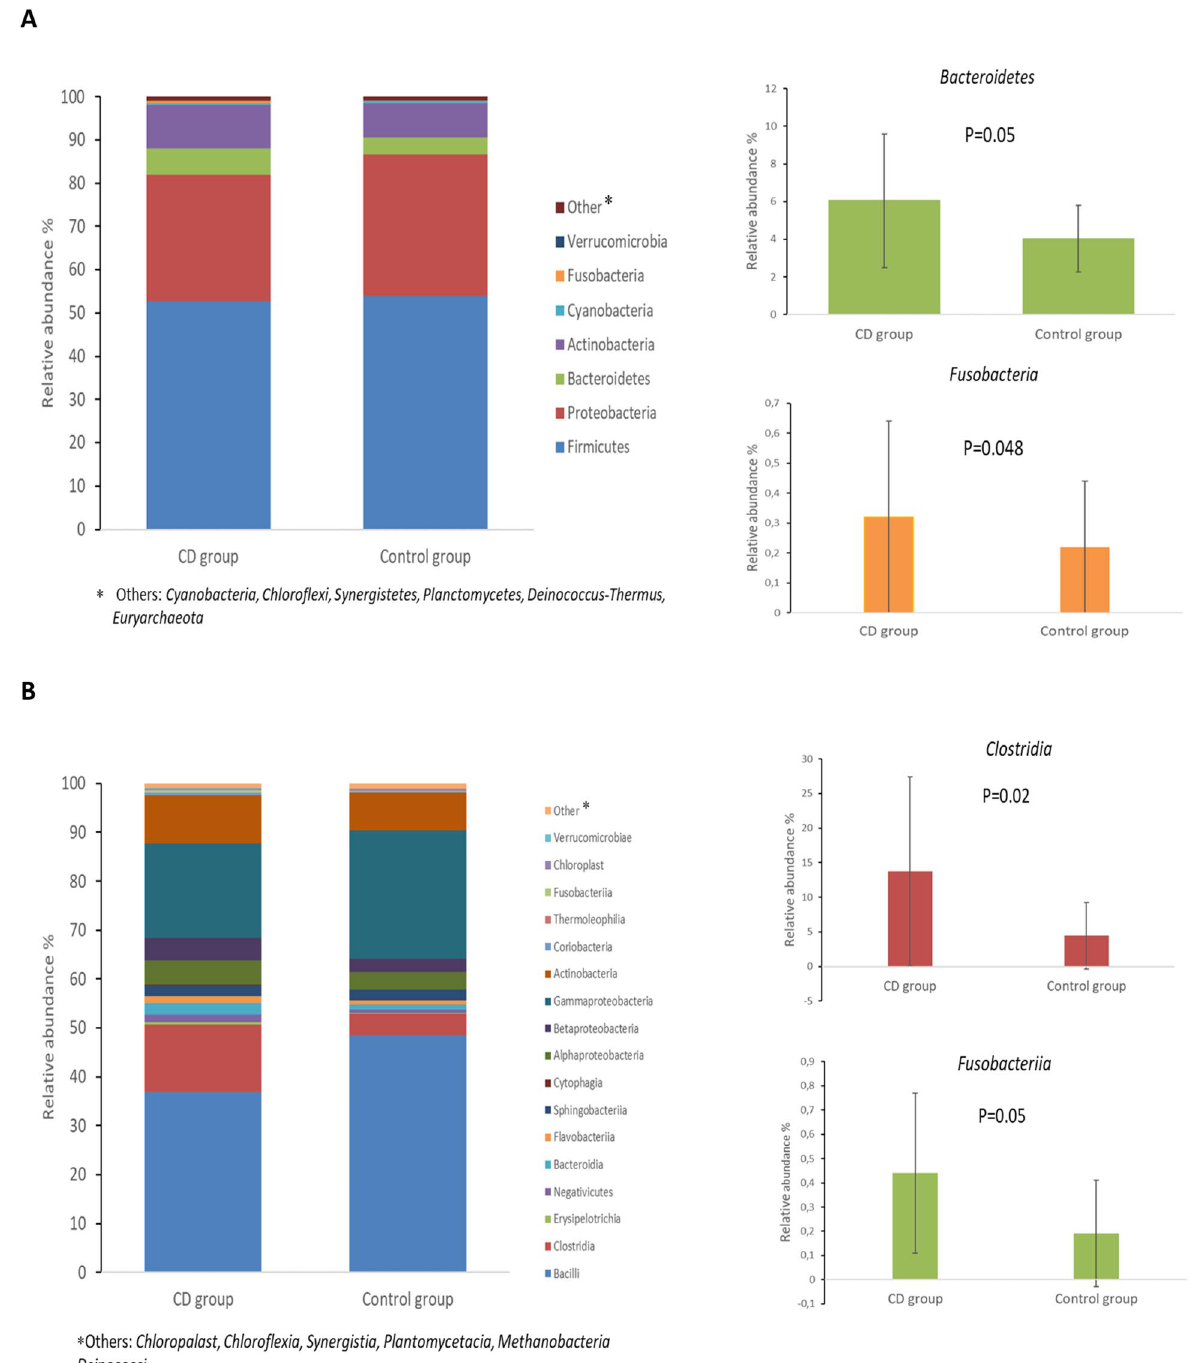
Figure 1. The relative abundance (median) of most frequent (A) phyla, (B) classes and (C) genera of microbial communities in maternal breast milk samples [coeliac disease (CD) versus control group]. Statistically significant relative abundances (mean ± SD) based on different taxonomic levels: phyla ( Bacteroidetes, Fusobacteria ); classes ( Clostridia, Fusobacteriia ) and genera ( Leptotrichia, Akkermansia, Anaerococcus, Shpingomonas and Actinomyces